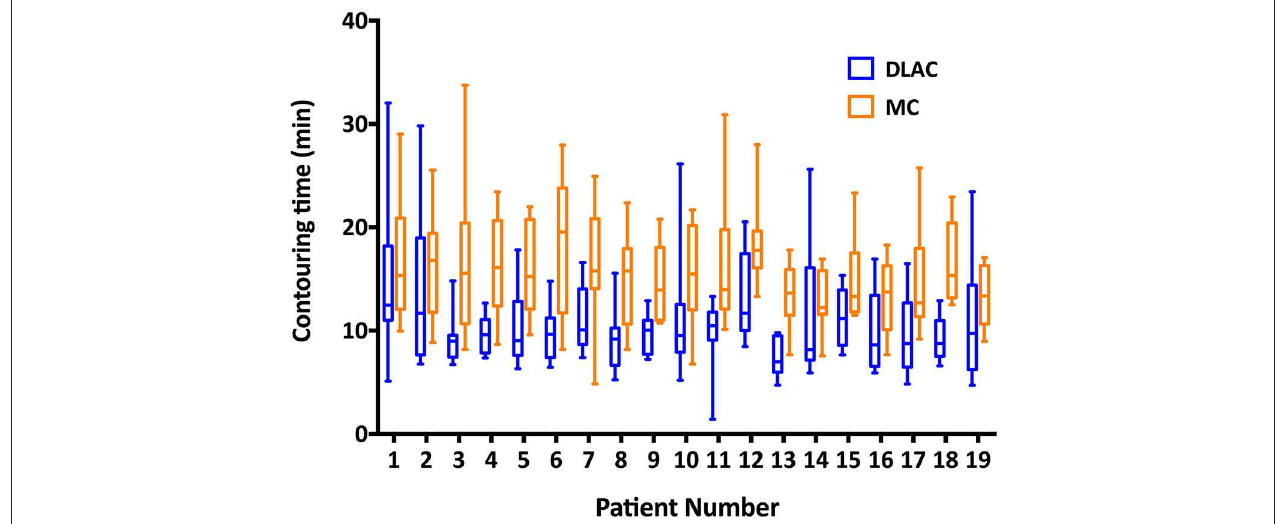
FIGURE 5 | Contouring time of the DLAC (blue boxes) and MC (yellow boxes), with whiskers from the 5–95th percentile displayed for each individual patient. DLAC, deep learning-assisted contour; MC, manual